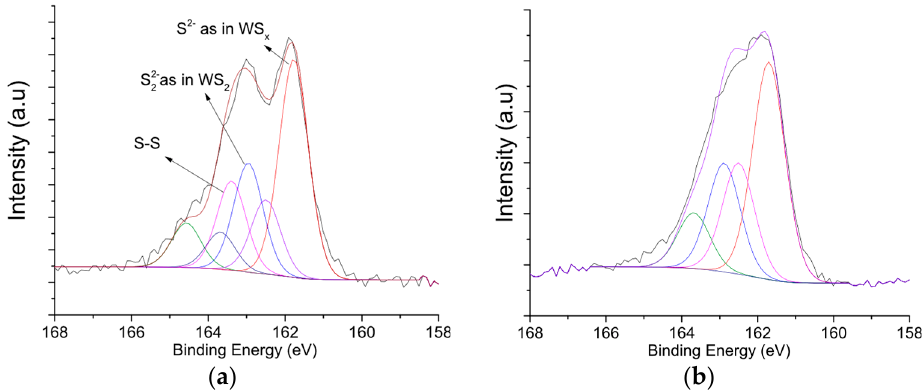
Figure 6. XPS spectra obtained in the S2p region of interest: ( a ) D3-17 before etching; ( b ) D3-17 after etching.